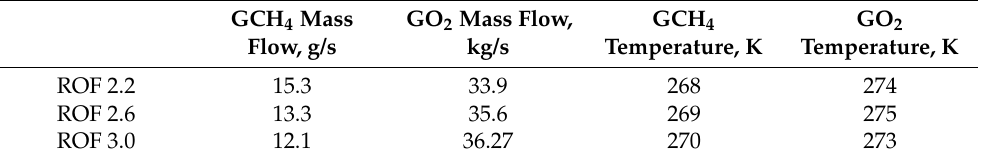
Table 2. Mass flows and temperatures of the components at different